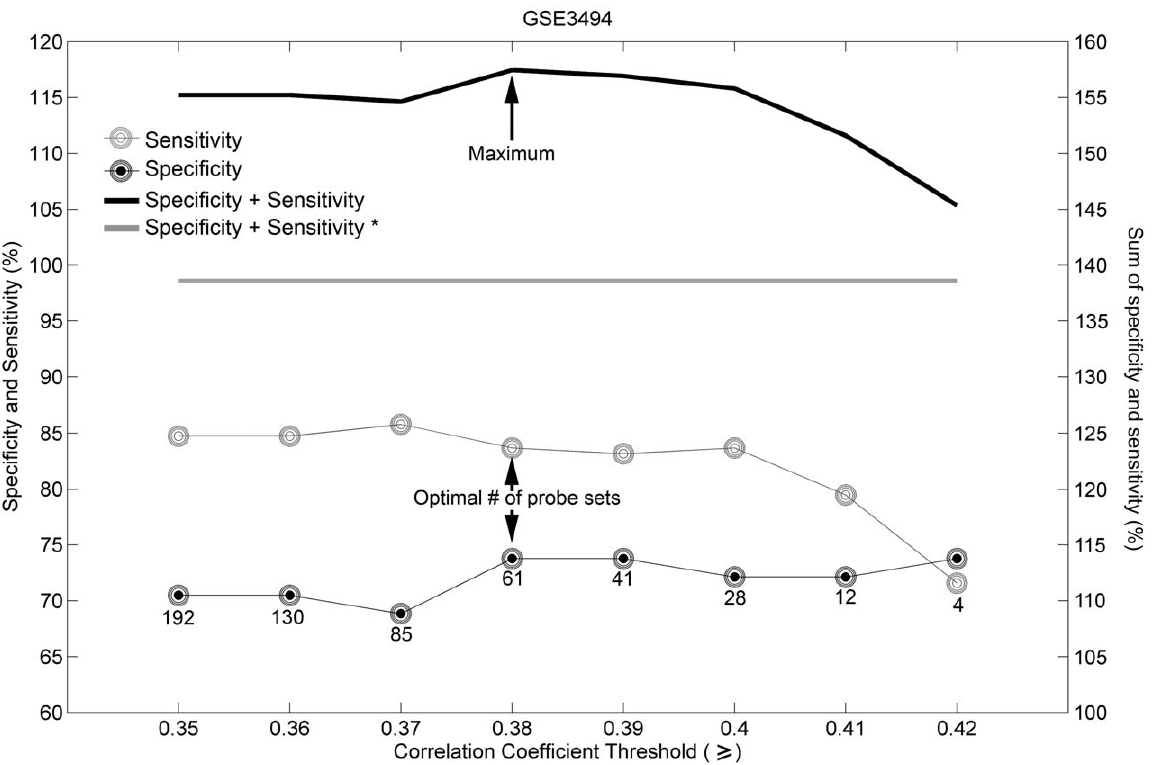
Figure 5. Selecting set of genes predictive of PR status based on sensitivity and specificity. The cutoff is based on Spearman rank correlation coefficients. The number of probe sets in each signature is marked by the number under the lowest curve. Black filled circles – specificity; gray circles – sensitivity; black line – sum of specificity and sensitivity. The optimal number of probe sets is 61, with Spearman correlation coefficient cutoff set at 0.38. Gray line and ‘‘*’’ indicate the sum of specificity and sensitivity of the prediction obtained by using a single ‘‘best probe set’’ (‘‘219197_s_at’’).